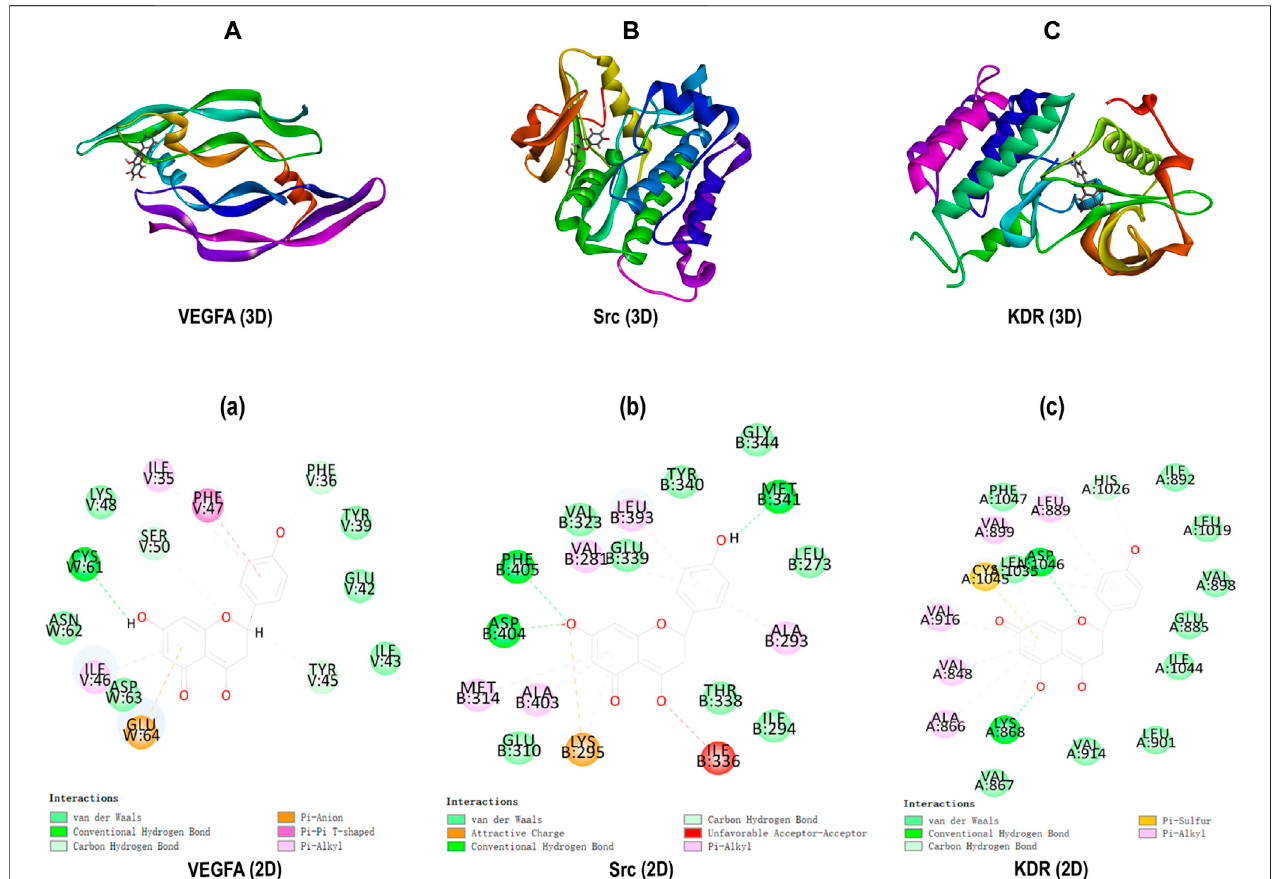
FIGURE 8 | Molecular docking. (A-C) 3D docking for Nar in the active binding pocket of VEGFA, Src and KDR. (a-c) 2D interaction patterns between Nar and VEGFA, Src and KDR.